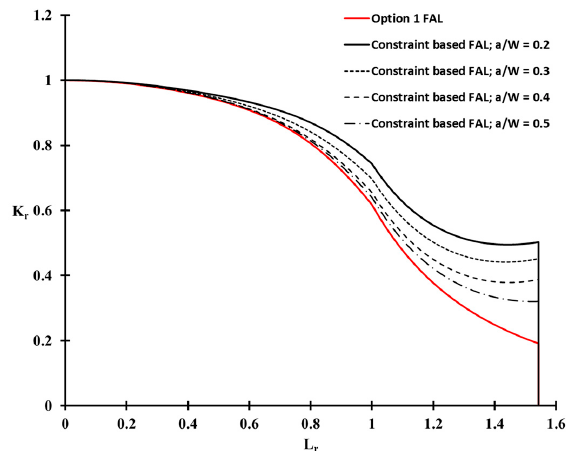
Figure 11. Comparison of the conventional and constraint-based FADs for various crack ligament ratios. 5.4. Fracture Assessment for the Welded Joints of Al 5083-O with a Surface Flaw